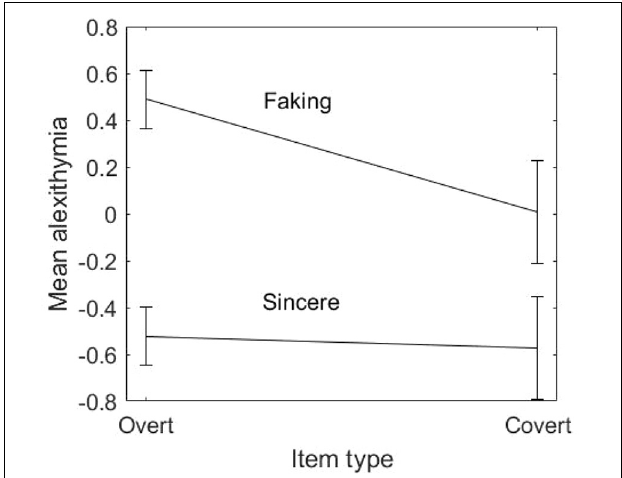
FIGURE 1 | Average alexithymia (and 95% confidence intervals) of respondents in the sincere and faking condition, estimated on overt and covert